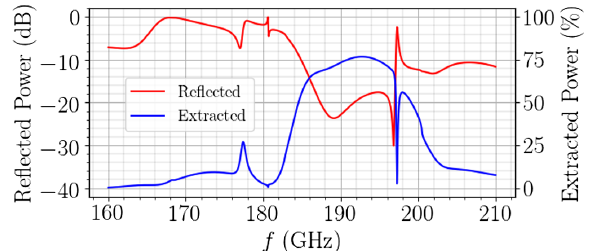
FIG. 5. Reflection and extraction of the TM 01 mode from the TM 01 coupler. The extracted power is divided equally among the four rectangular waveguide outputs.